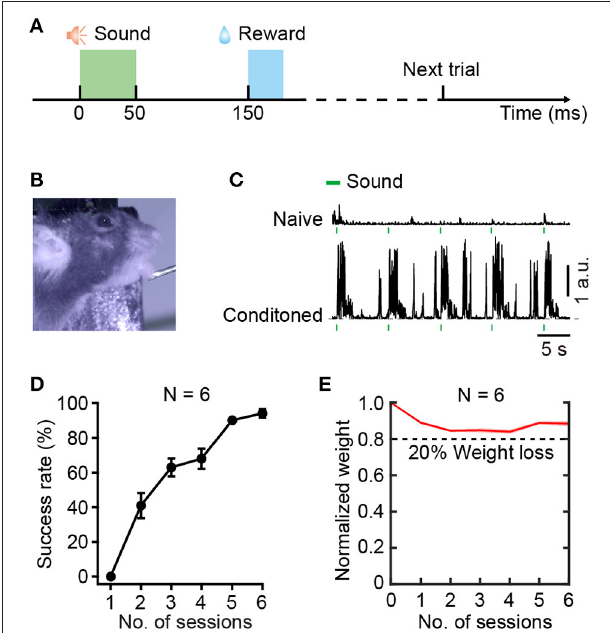
FIGURE 2 | Training for the sound-triggered licking task based on water restriction. (A) Schematic of the event timing for each trial of training. (B) A head-fixed mouse performing the licking task. (C) Licking behaviors before (upper) and after learning (lower), quantified by tongue movements. (D) Average success rate of task performance across 6 training sessions over 3 days ( N = 6 mice). (E) Normalize weight change across 6 training sessions over 3 days ( N = 6 mice). The dashed line indicates 20% weight